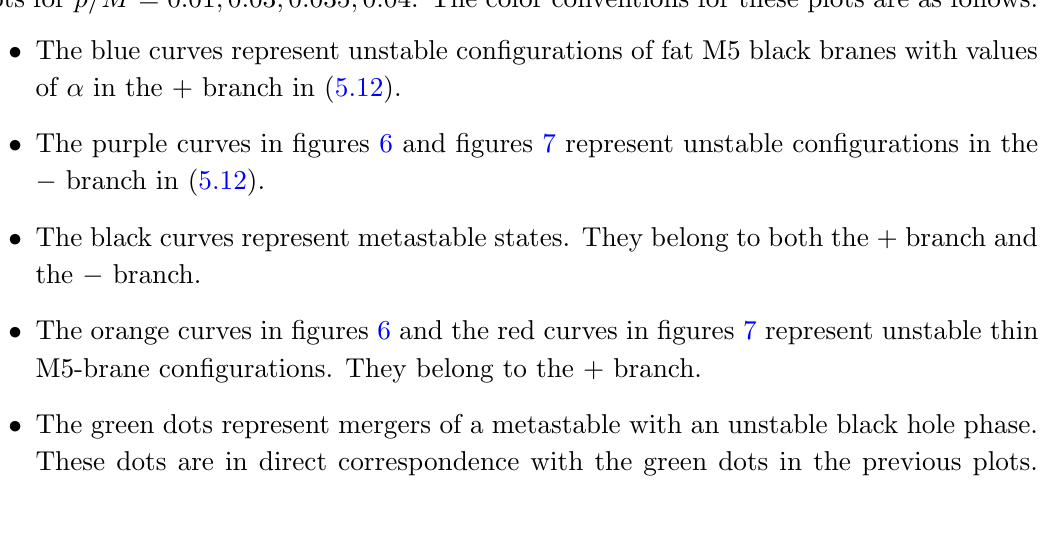
Figure 5 . Plots of the fixed- S counterparts of the plots in figures 3 and 4 on the right. The left at p/ ˜ M = 0 . 03 and the right plot V plot depicts V S Regime III: high p/ ˜ M